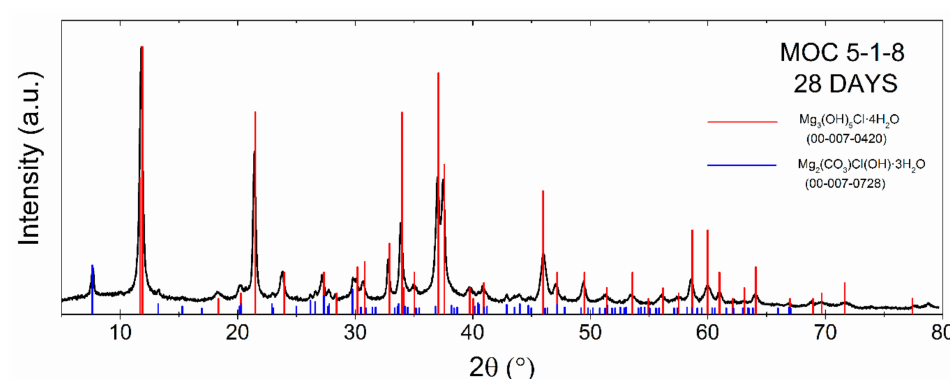
Figure 2. Sample composition over time obtained by Rietveld analysis.